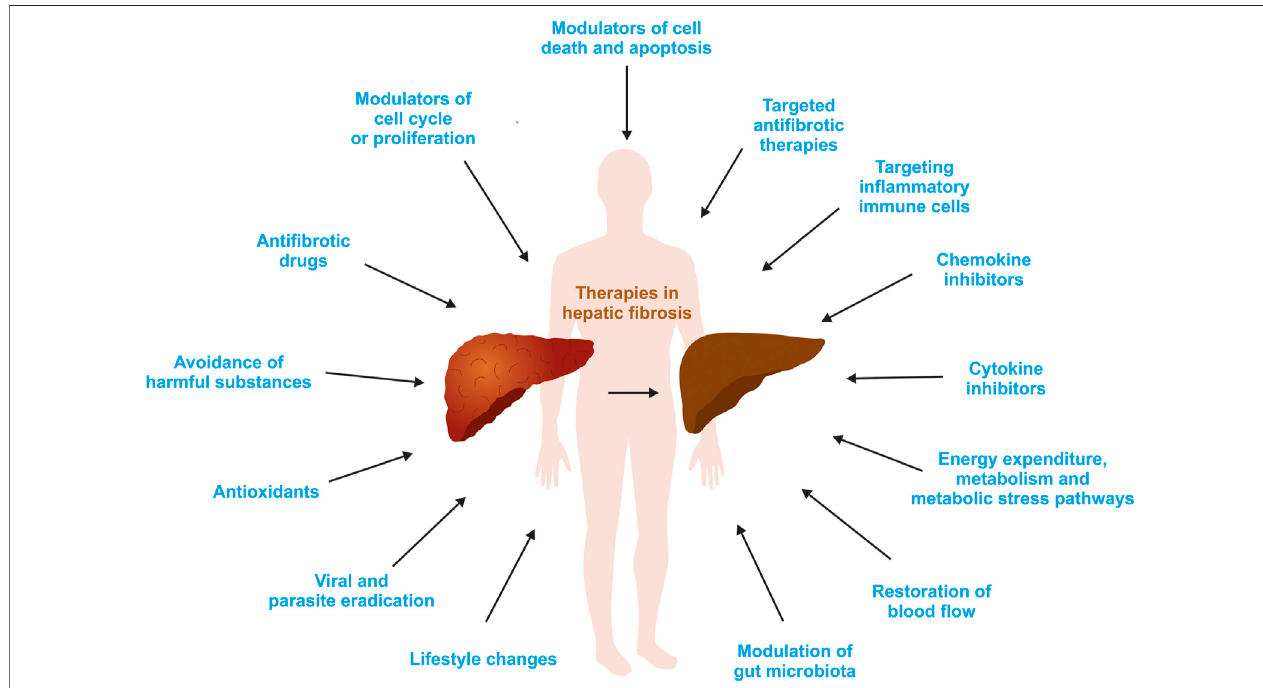
FIGURE12| Potentialtherapeuticoptionsforliver fi brosis.Basedonthefactthathepatic fi brosisisdrivenbydifferentmediatorsandpathways,thereisaplenitude ofpossibilitiestointerferewiththisprocess. Formoredetailsseetextorreferto(Schonetal.,2016;Weiskirchen2016;TackeandWeiskirchen,2018;Weiskirchenetal., 2018; Levada et al.,